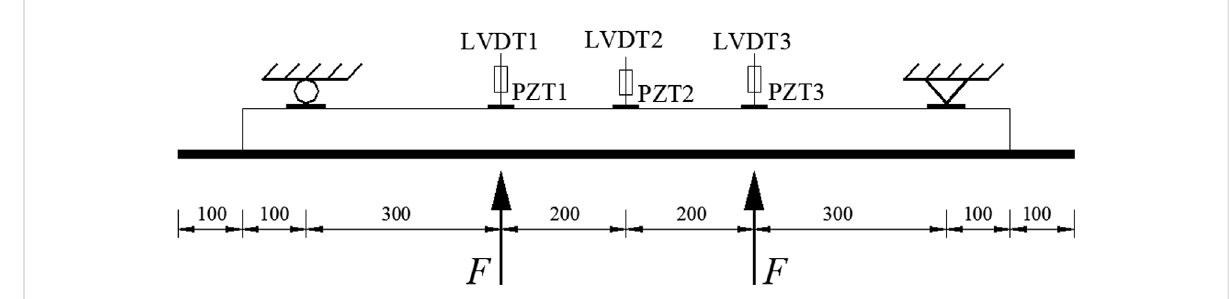
FIGURE 2 Diagrams of the loading and instrumentation devices.